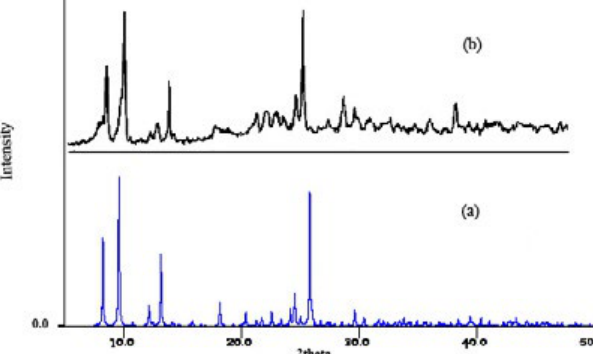
Fig. 1. XRD patterns: (a) simulated pattern based on single crystal data of compound 1, (b) nano-particles of compound 1